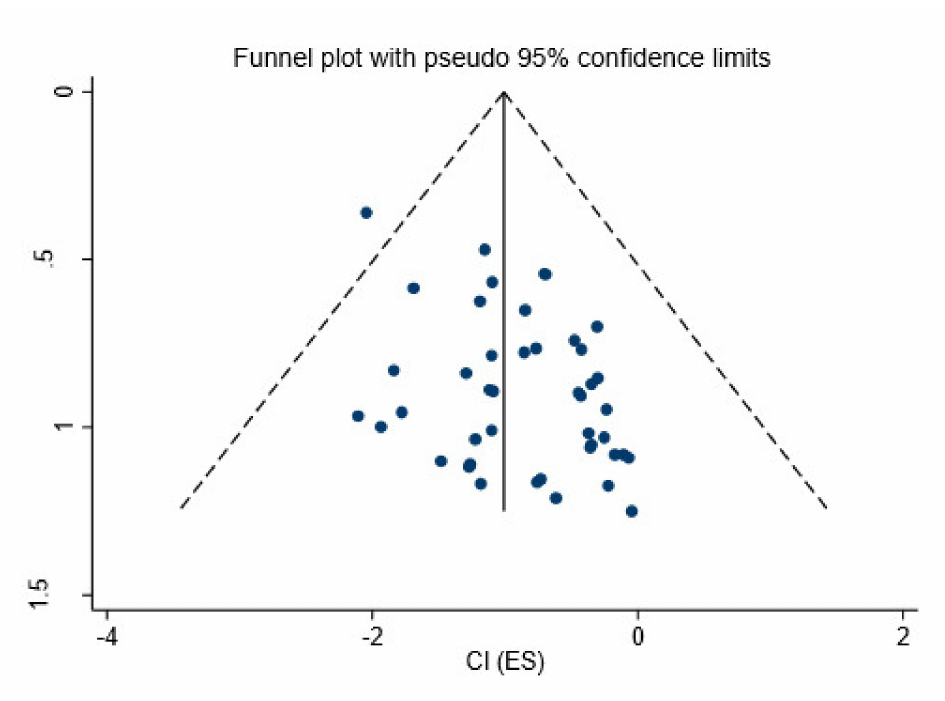
Figure 6. Funnel